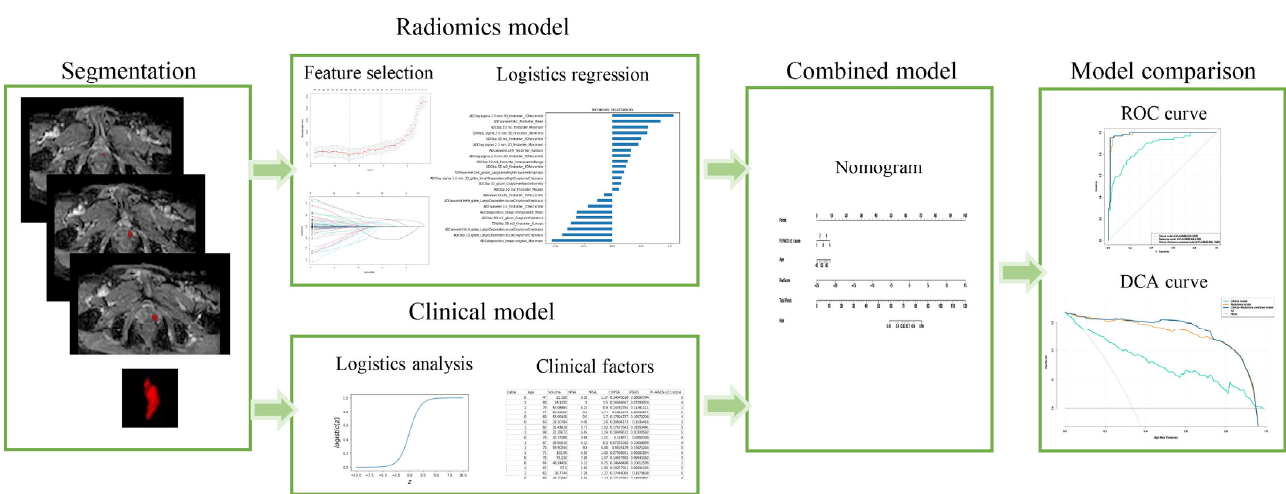
Figure 2. The workflow of this study.